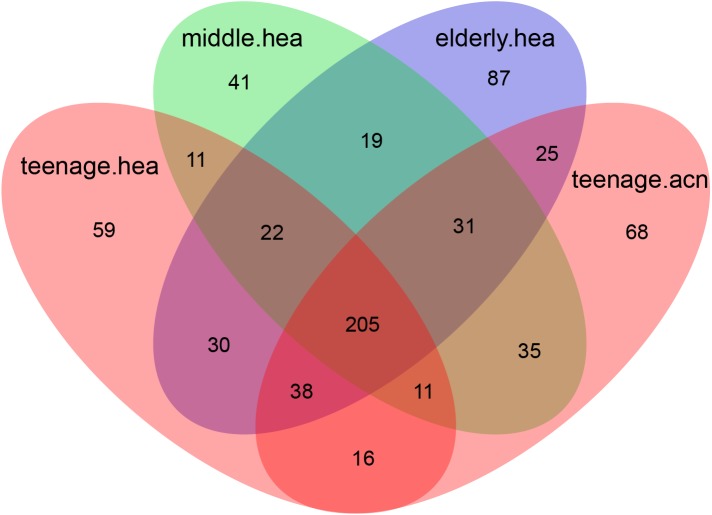
Venn diagram illustrating the overlapping GLOTUs among the four merged subject groups.